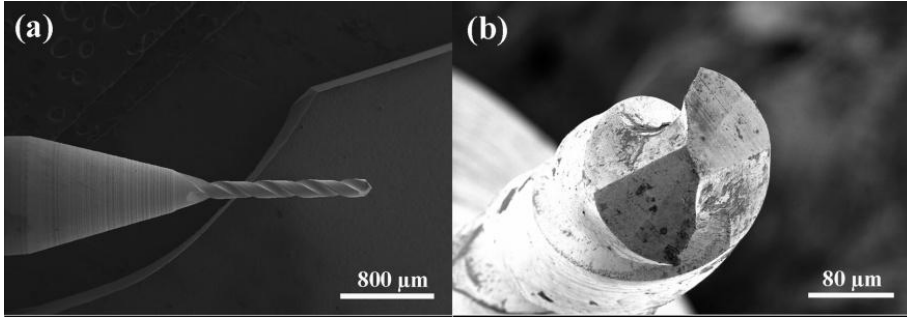
Figure 1. Images of as-received micro drills.